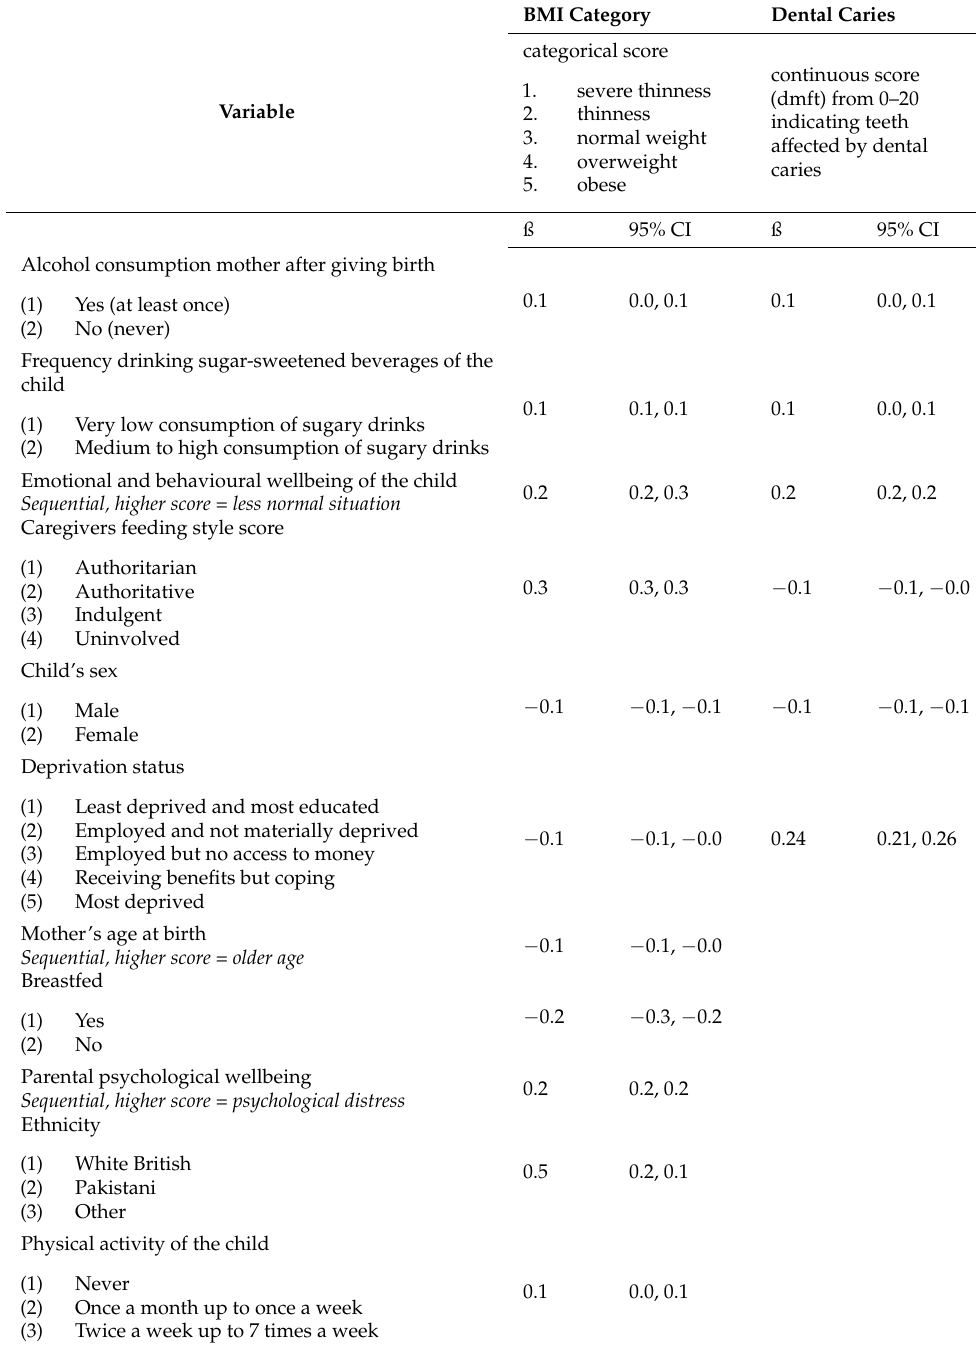
Table A3. Determinants for childhood overweight/obesity and dental caries in children (standard- ized